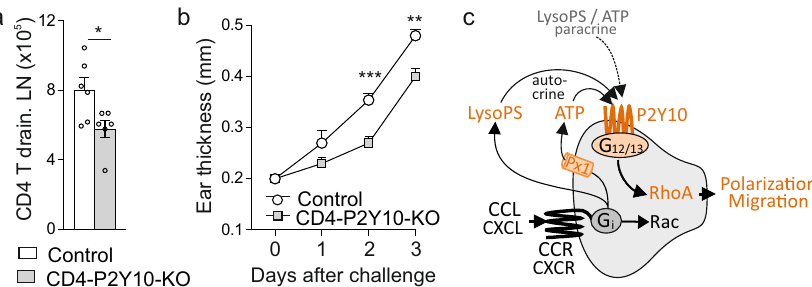
Fig. 7 P2Y10-dependent facilitation of migration contributes to CD4-mediated responses outside the CNS. Delayed type hypersensitivity in control mice and CD4-P2Y10-KOs: Flow cytometric analysis of CD4 T cells numbers in draining cervical lymph nodes 48 hrs after challenge ( a , 6 mice per group; * p = 0.028), increase in ear thickness after challenge ( b , 5 mice per group; ** p = 0.001; *** p < 0.001). c Schematic overview of fi ndings: Chemokine stimulation of CD4 T cells results in the release of LysoPS and ATP, which in turn trigger a P2Y10-dependent RhoA activation and consecutive facilitation of polarization and migration. Data are means± SEM; comparisons between groups were performed using two-tailed unpaired Student ’ s t- test ( a ) or two-way ANOVA with Tukey ’ s multiple comparisons test ( b